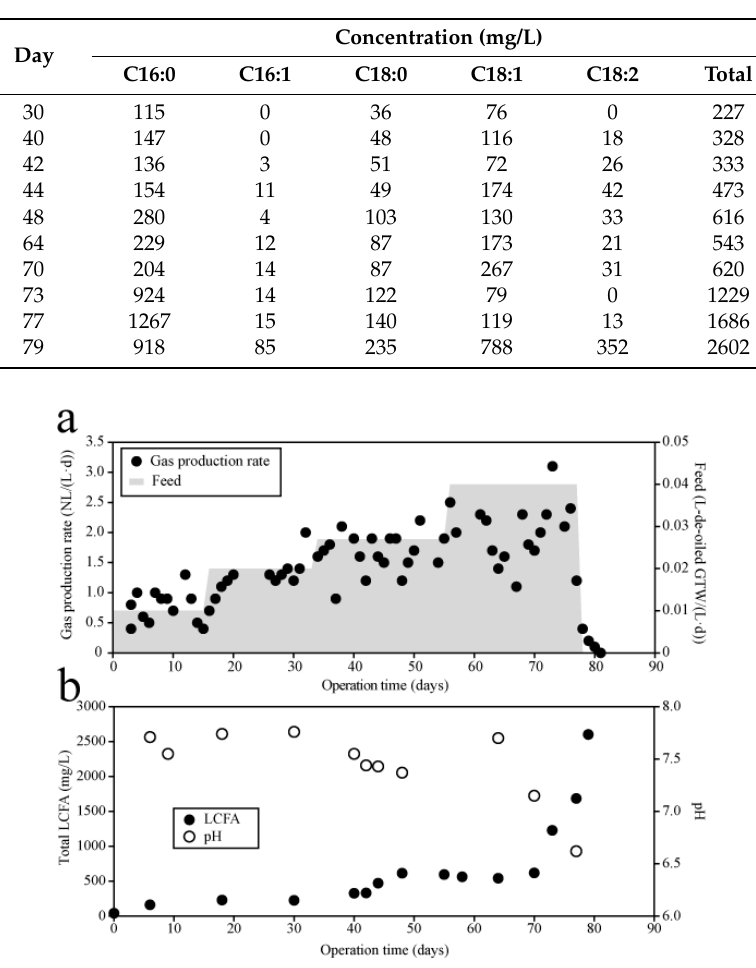
Figure 4. ( a ) Time courses of gas production rates and feeding rate of de-oiled grease trap waste (GTW); and ( b ) The change of pH and long-chain fatty acids (LCFA) concentration during the semi-continuous experiment.